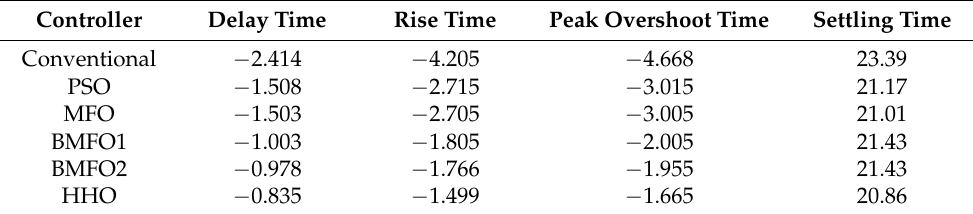
Table 15. Graph analysis of Area1 frequency with various controllers under contract violation